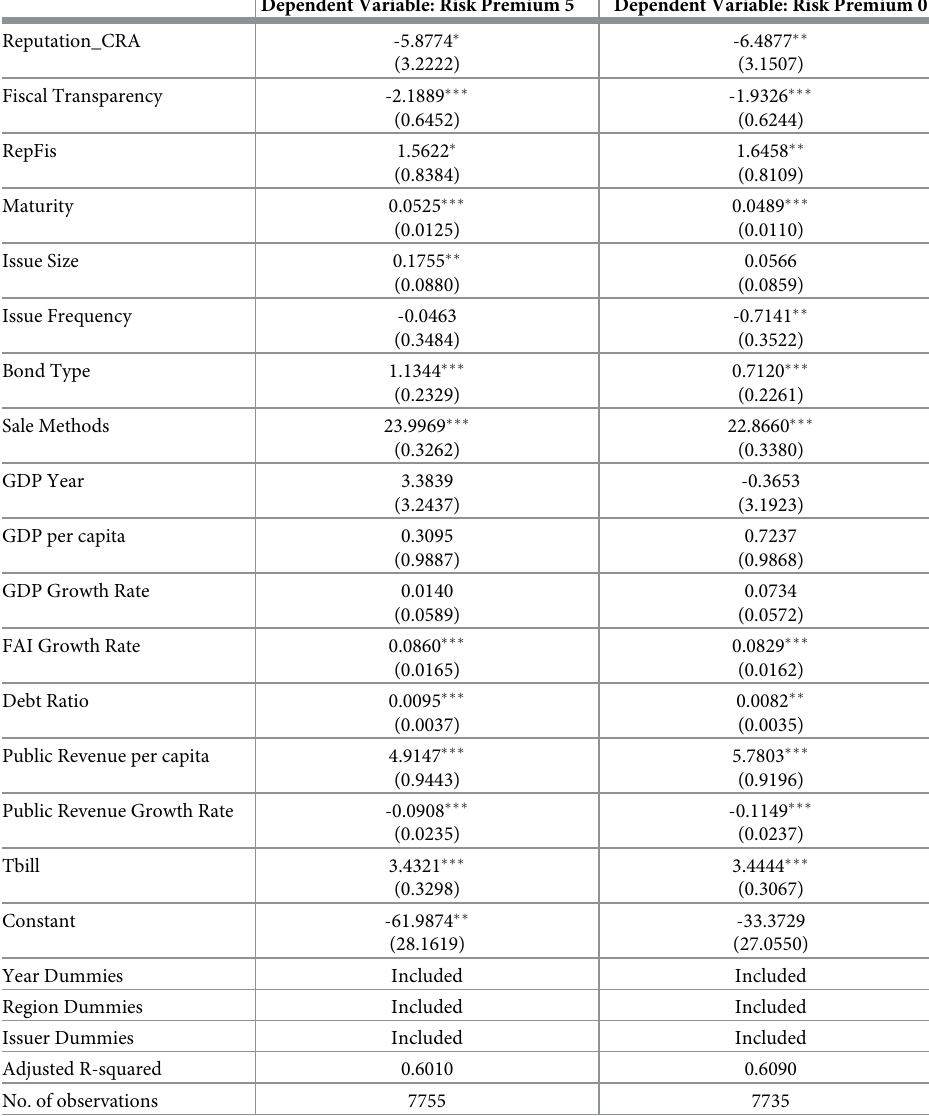
Table 14. Regression results by excluding negative risk premium observations. This table reports the estimates of the baseline regression Eq (1), excluding negative risk premium observations, with robust standard